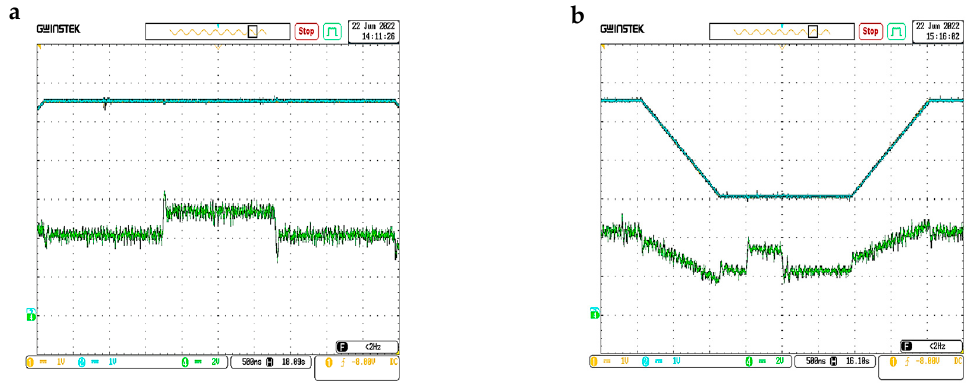
Figure 20. Zoom 2 of electromagnetic torque and speed response for speed profile 1 and 2.